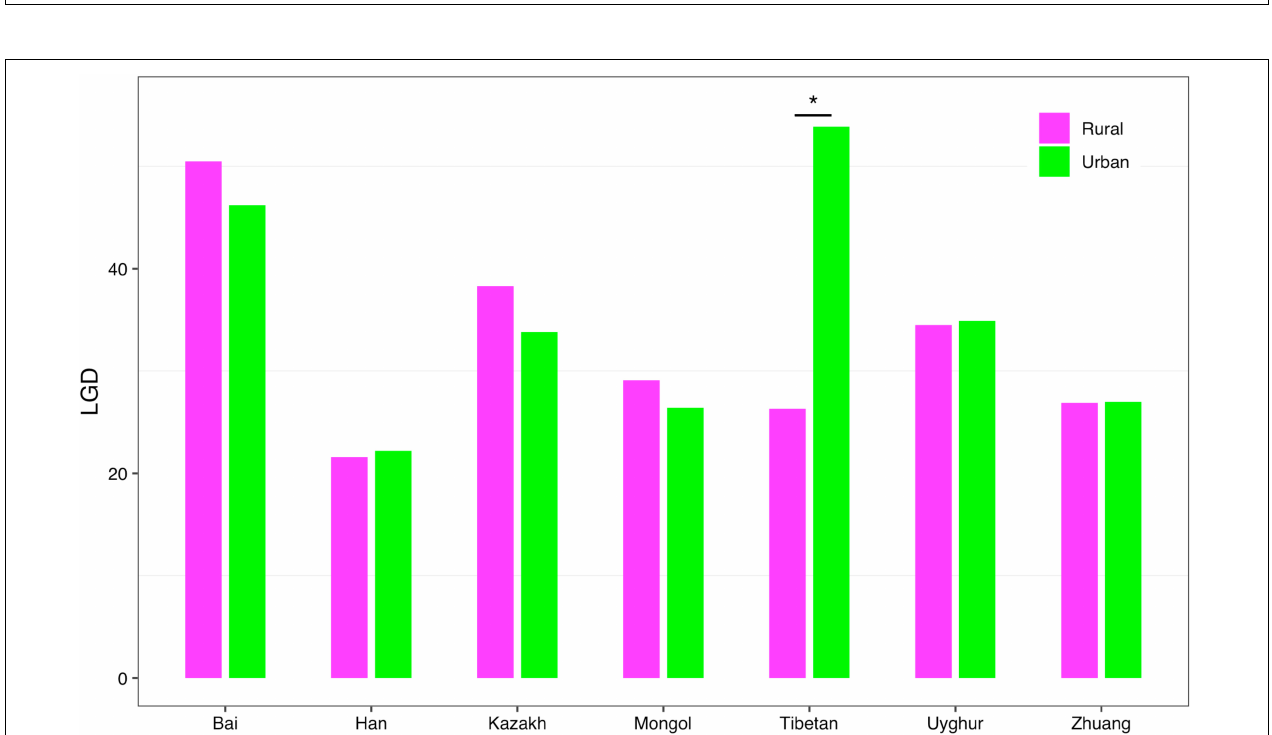
FIGURE 8 | The LGD profiles of all cohorts from Scheme 1B at the species level when diversity order q = 0 (“*” indicated a significant difference between pairwise comparisons).